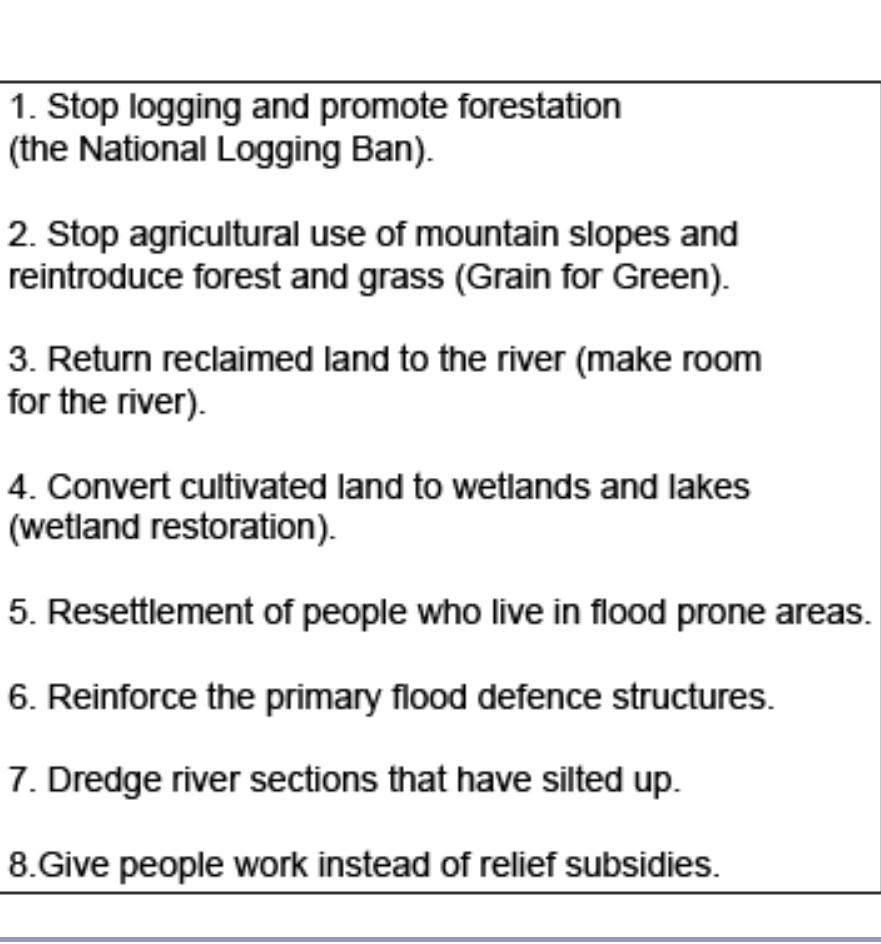
Fig. 2 . 32 character policy. The name refers to the number of Chinese characters needed to formulate the various policy